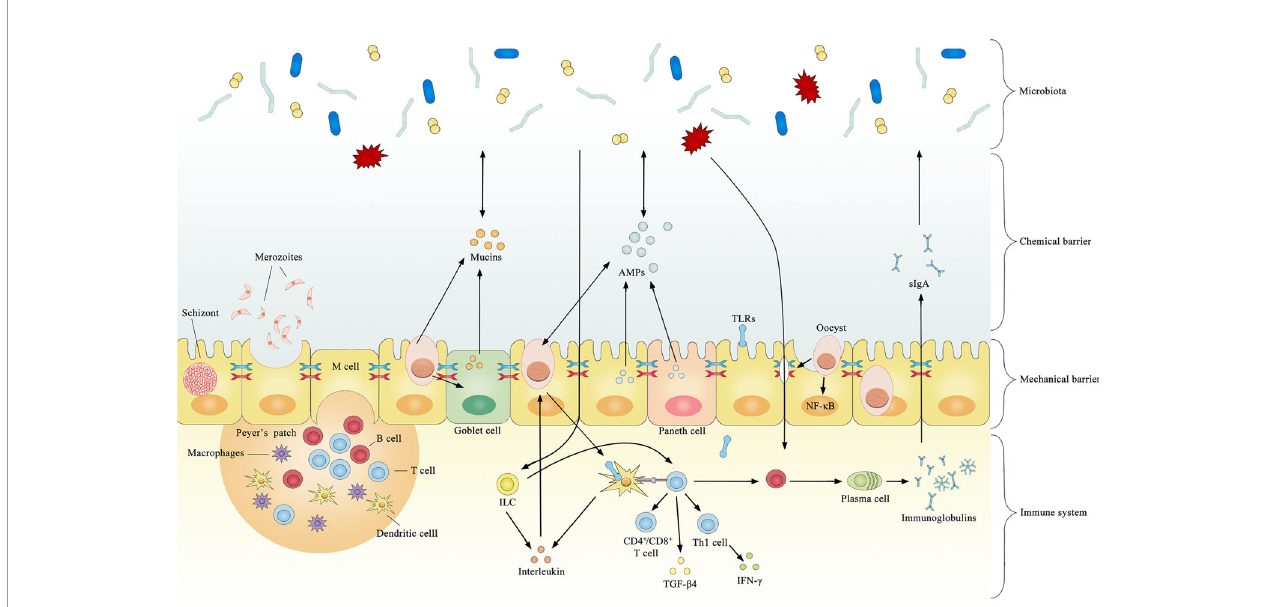
FIGURE 1 | Summary of documented mechanisms by which infection with coccidia may indirectly interact with the gut microbiota.